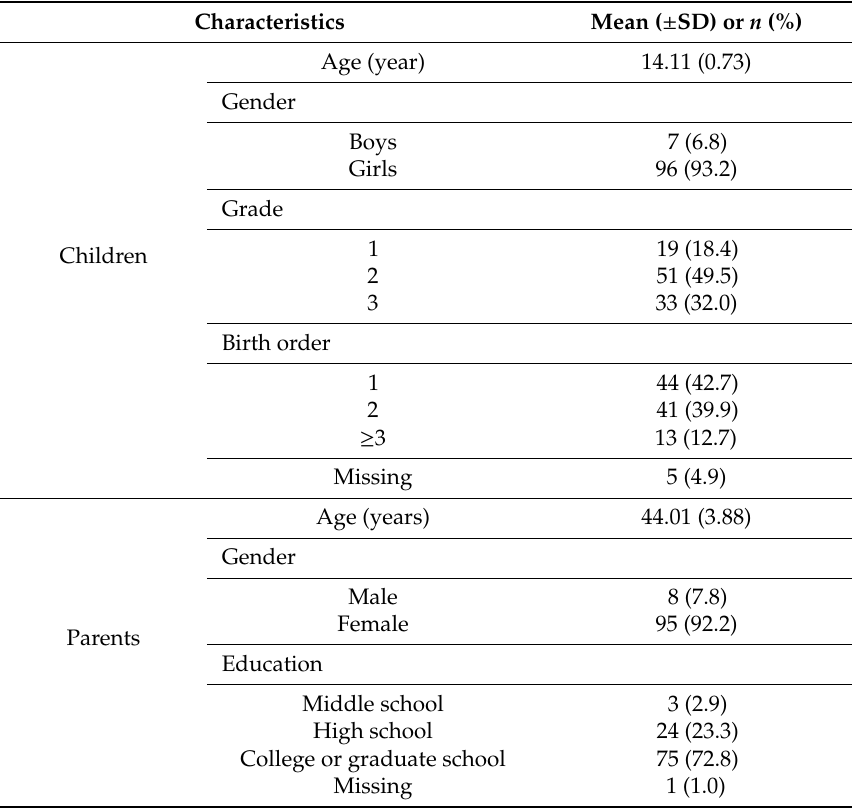
Table 1. Characteristics of participants ( n = 103 parent–child